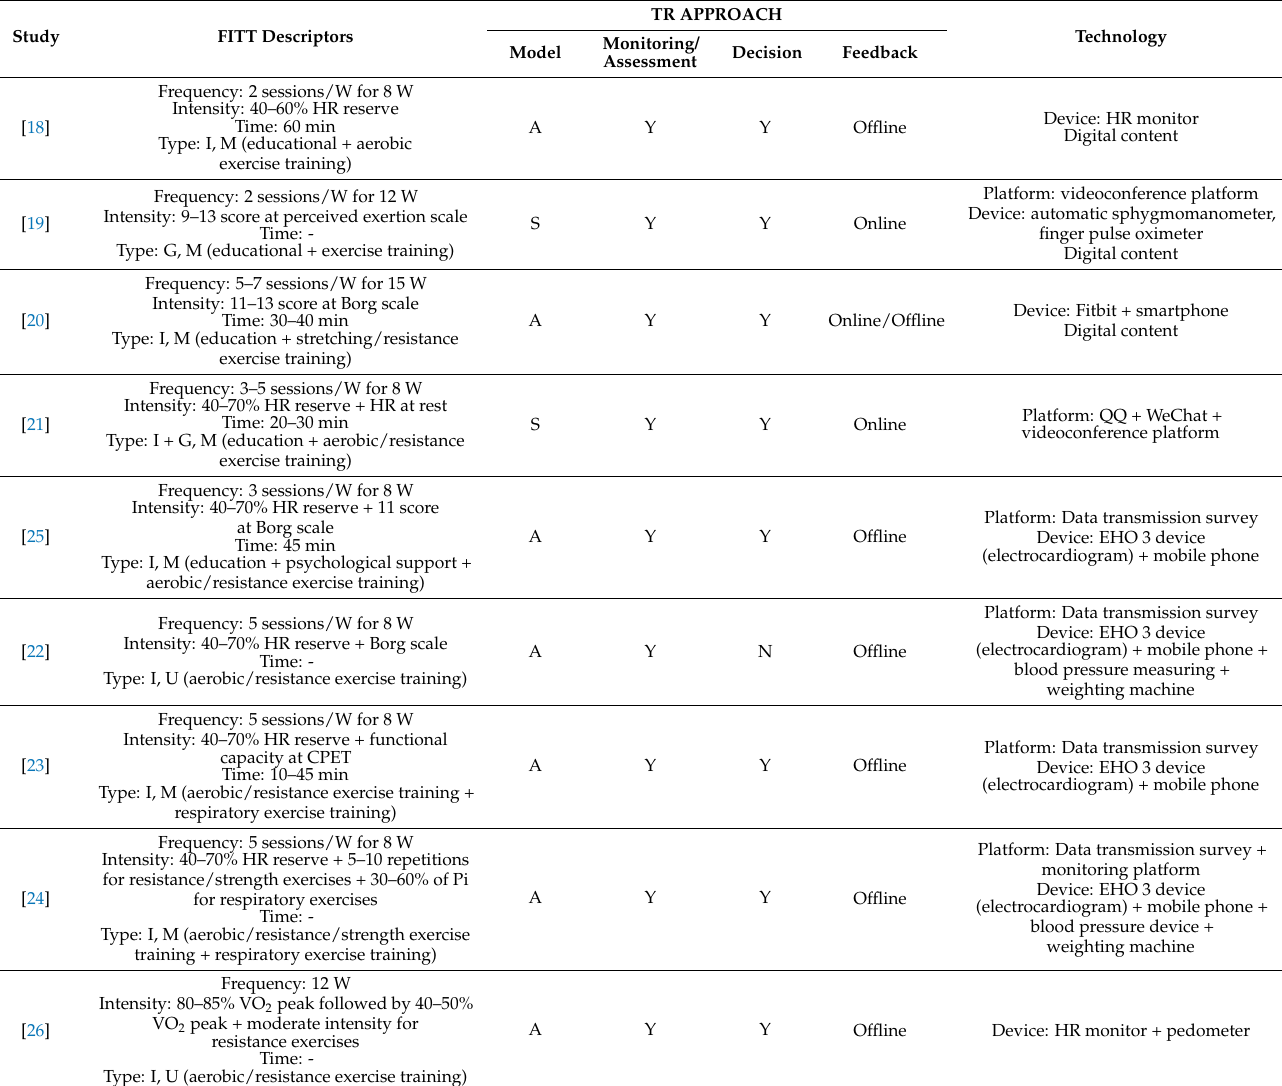
Table 3. Characteristics of TR program. HR = heart rate; I = individual; G = group; W = week; A = asynchronous; S = synchronous; VO 2 = max oxygen consumption; EHO = event Holter.